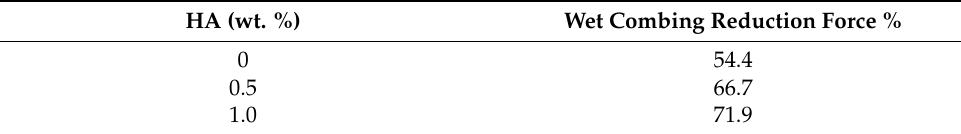
Table 3. Effect of HA Concentration with ASL on Wet Combing Reduction Force. HA (wt. %)